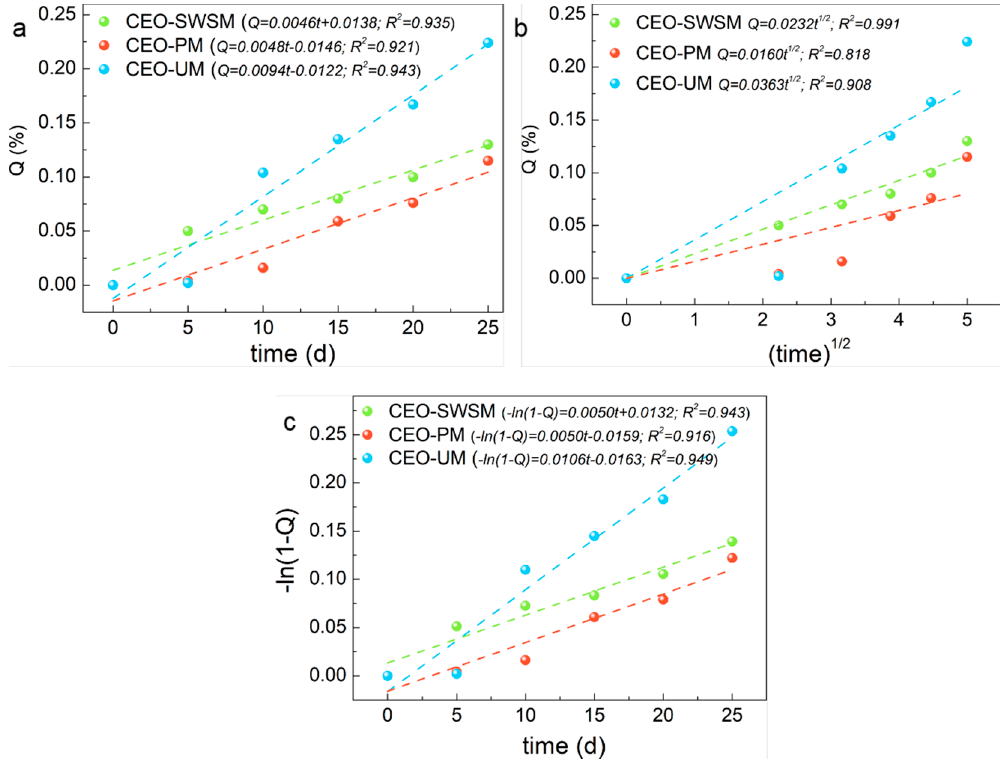
Figure 9. Release kinetics fitting equations of the CEO-SWSM, CEO-PM, and CEO-UM: ( a ) zero-order kinetic model, ( b ) Higuchi kinetic model, and ( c ) first-order kinetic model.